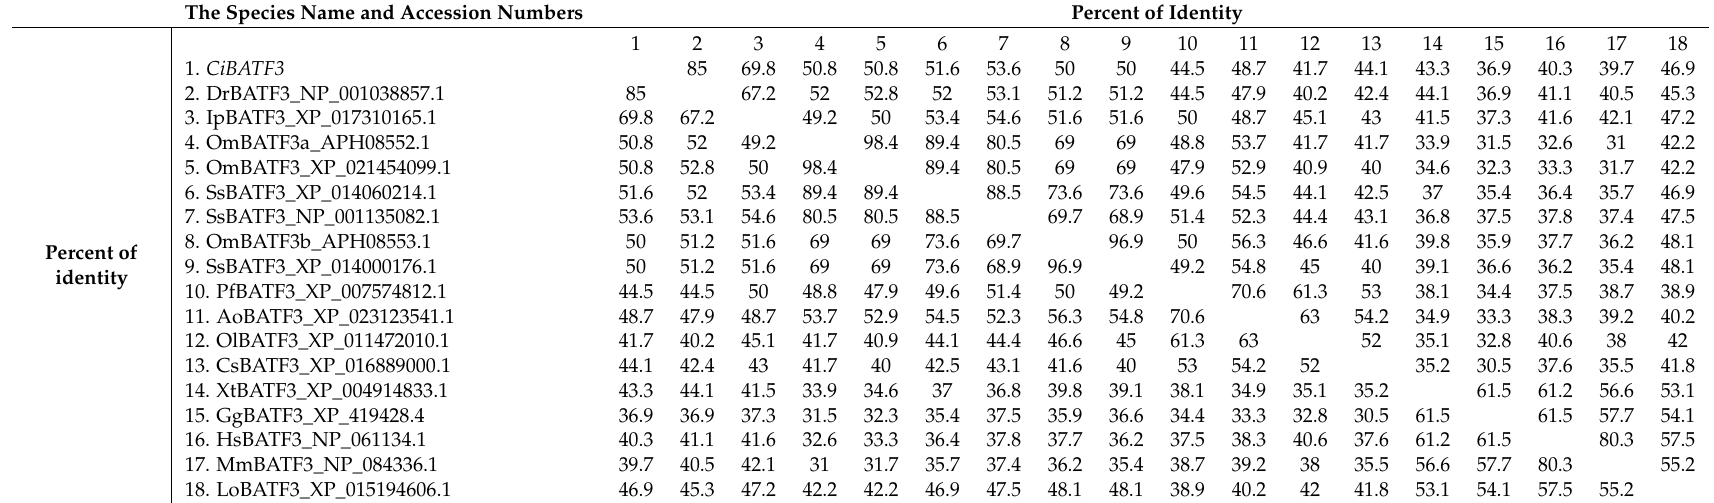
Table 1. Amino acid sequence similarity of CiBATF3 with other species by